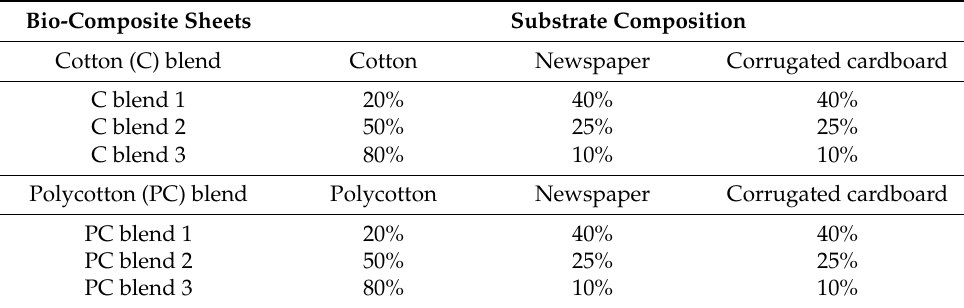
Table 1. Composition of bio-composite sheets.